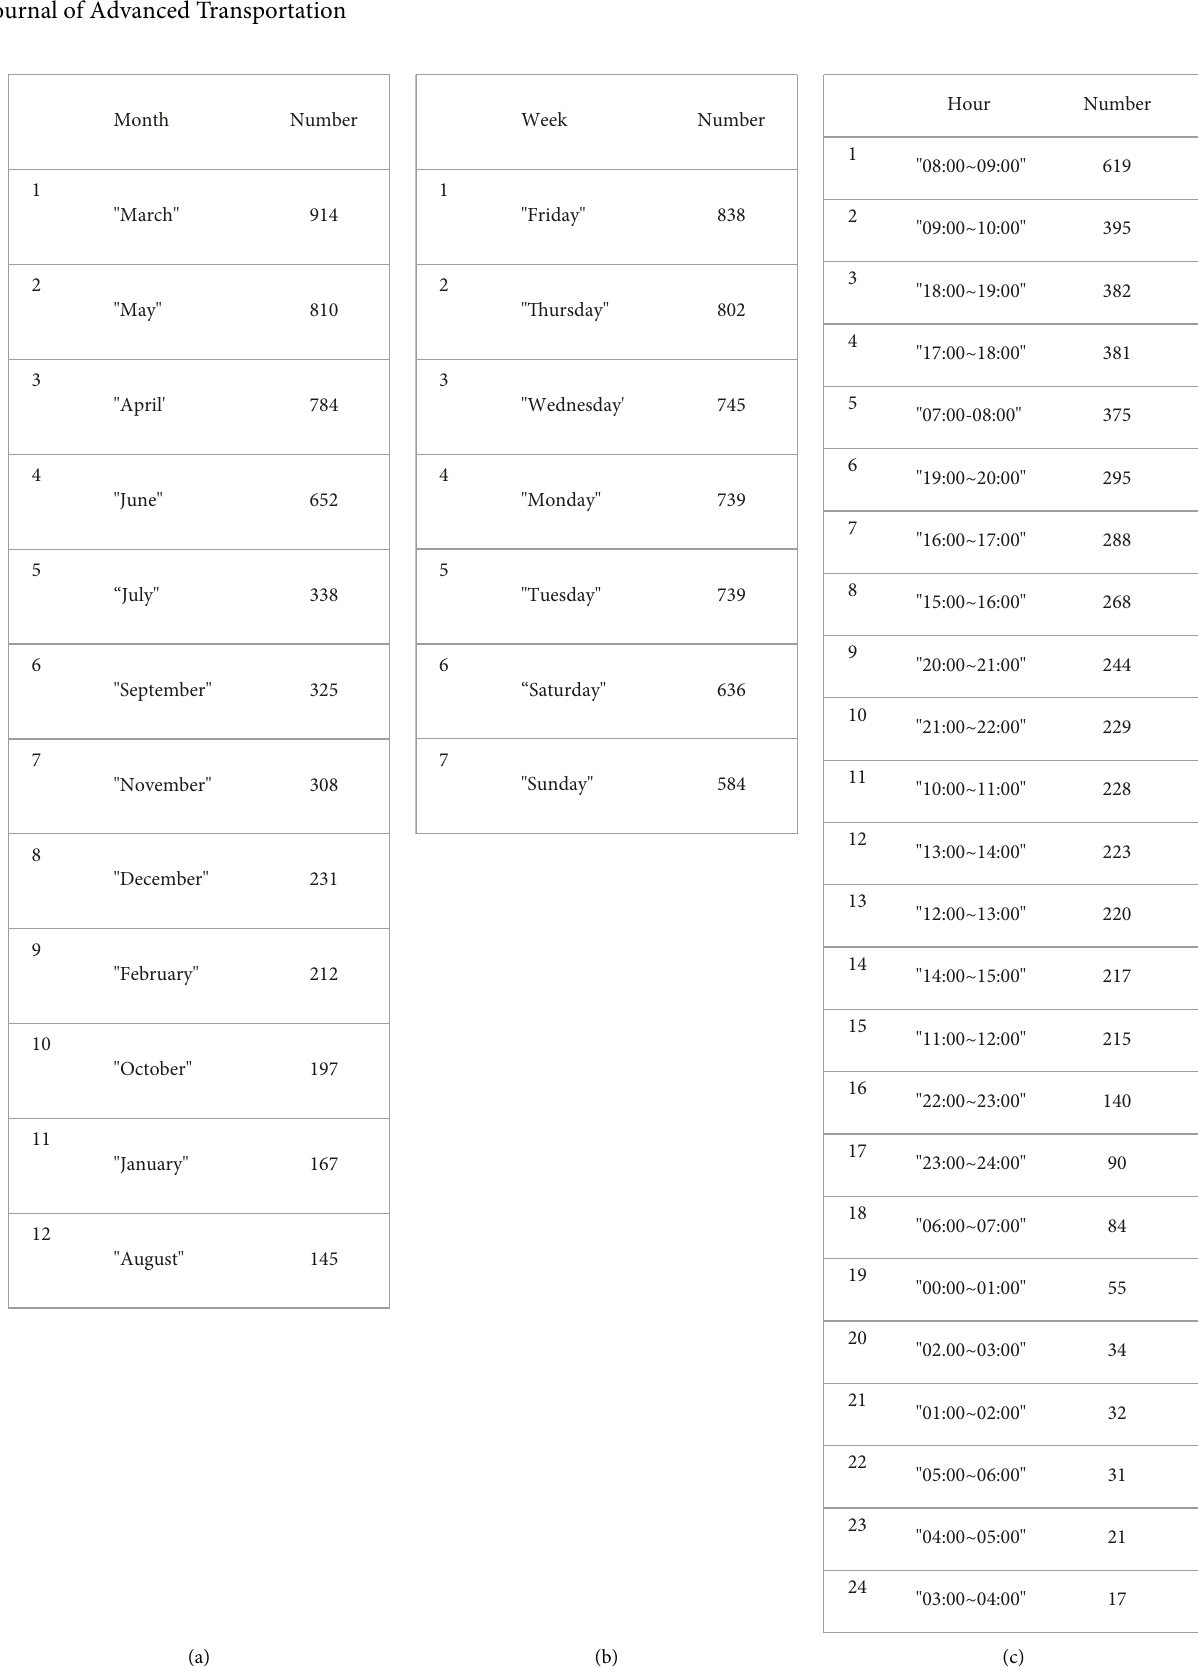
Figure 11: Query results of time factor in accident-prone areas, (a) statistics by month, (b) statistics by week, and (c) statistics by